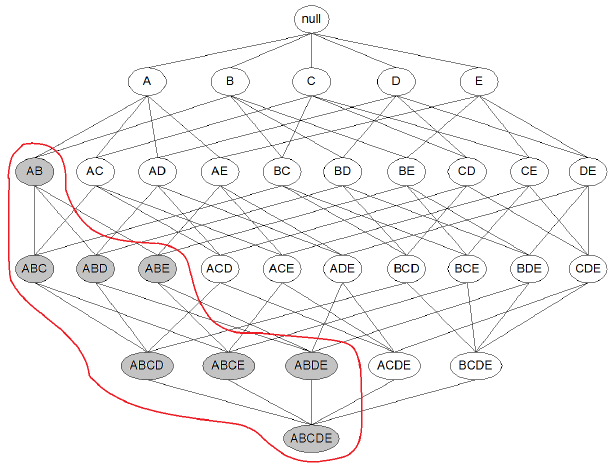
Figure 2. Combinations of five products for the purpose of generating association rules using the downward closing property to prune the